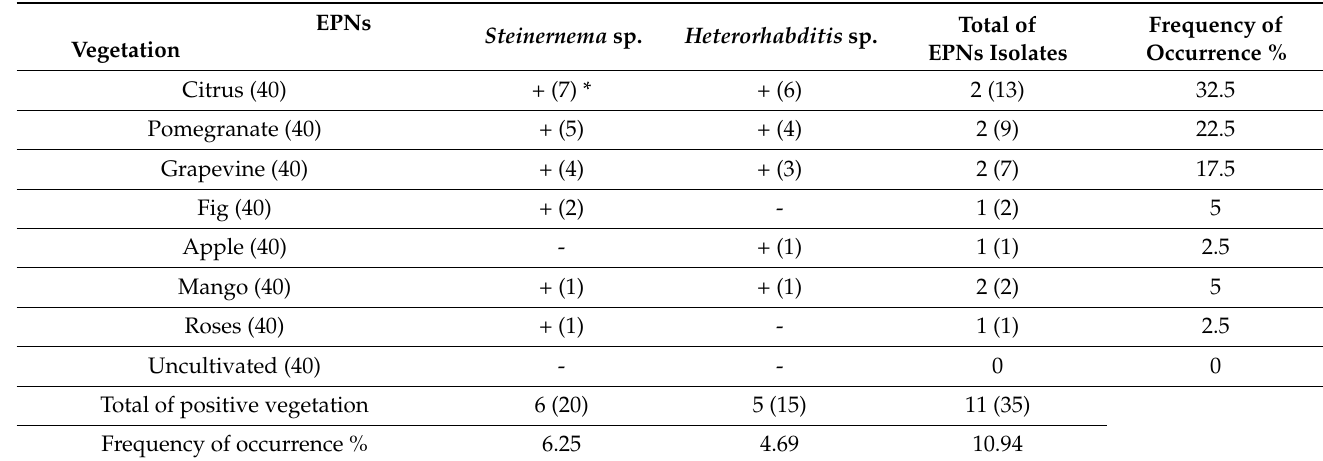
Table 2. Occurrence of EPNs isolated from the rhizosphere of vegetation at Taif governorate, Saudi